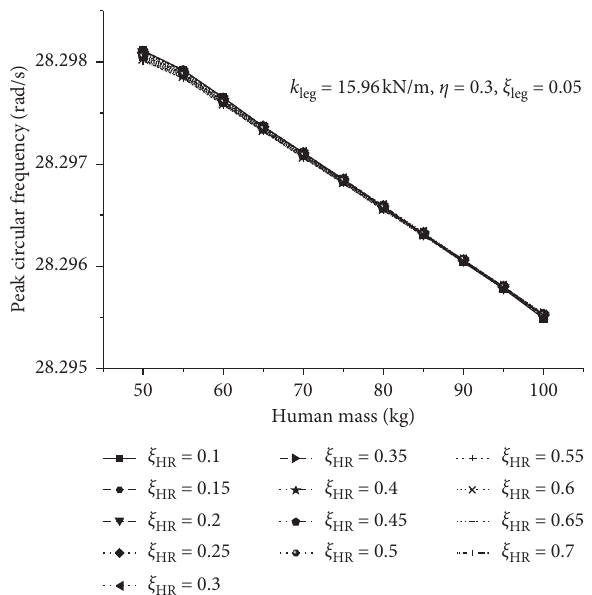
Figure 22: Peak frequency under leg stiffness 15.96kN/m, η � 0 . 3, and ξ